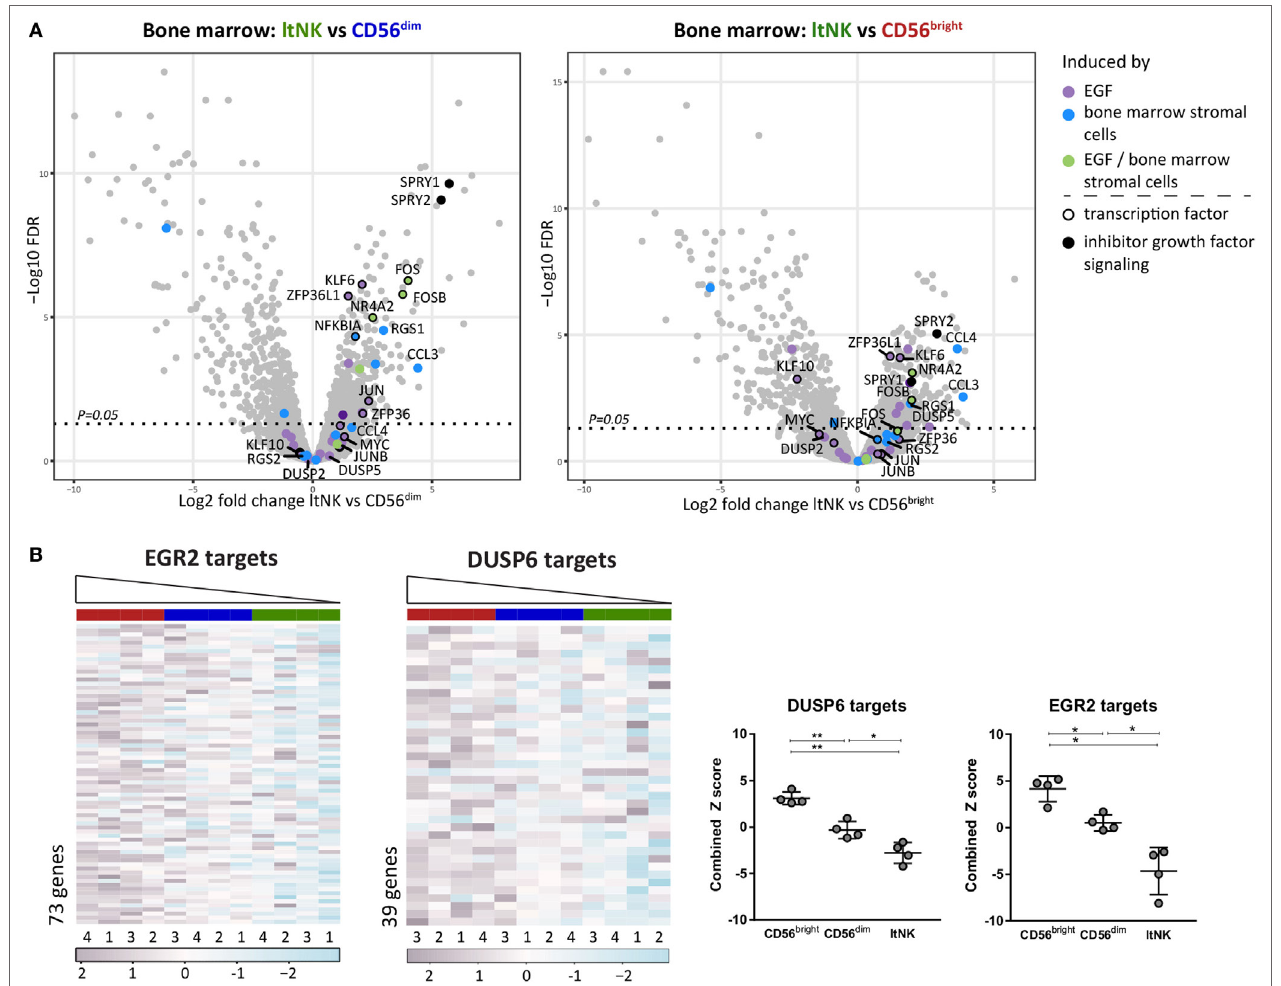
FigUre 5 | Gene set enrichment analysis (GSEA) reveals potential inducers of ltNK cell transcriptome. (a) The gene sets epidermal growth factor (EGF) signaling (M16311) and bone marrow (BM) stimulation (M5929) were enriched in ltNK cells, as identified by GSEA using CAMERA and the Broad institute gene set collections. The log2 fold change of ltNK versus CD56 bright or ltNK versus CD56 dim is plotted against the false discovery rate (FDR) in volcanoplots. Genes that were induced by either EGF, BM stromal cells, or both are depicted. SPRY1 and SPRY2 are two inhibitors of growth factor signaling. FDR, false discovery rate. (B) GSEA revealed that targets that are repressed by EGR2 (M12804) or DUSP6 (M7339) are downregulated in ltNK cells. Heatmaps show the normalized expression values of the corresponding genes, which are repressed by EGR2 ( n = 73) and DUSP6 ( n = 39). The column order is based on the combined Z score of each donor natural killer cell population (high → low). The combined Z score is a quantification of the overall expression level of the target genes. Error bars represent mean ± SD. * P < 0.05, ** P < 0.01, by one-way